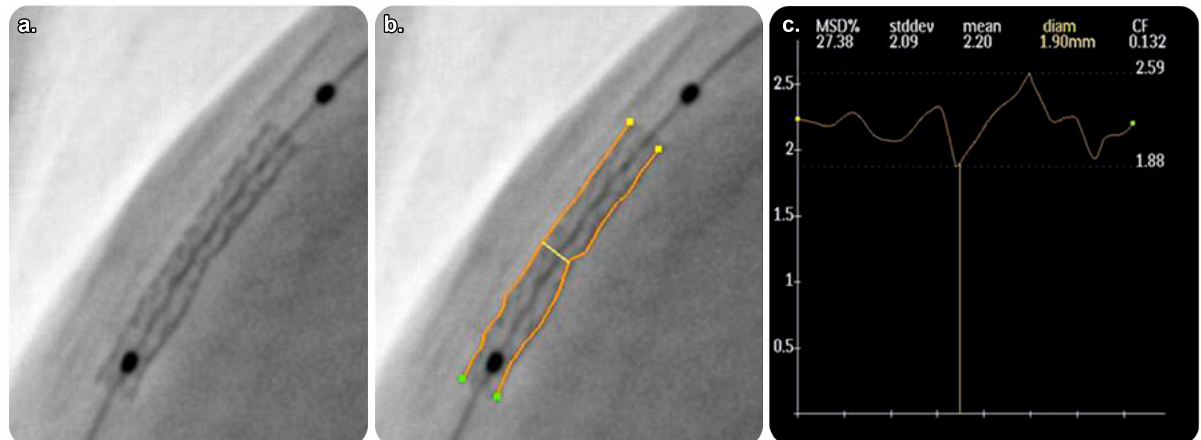
Figure 6. Quantitative analysis of StentBoost software images. ( a ) Enlarged and enhanced StentBoost image. ( b ) Manual tracing of longitudinal stent edges to avoid inadequate stent expansion. ( c ) Minimum stent diameter determined automatically. Reprinted from “Assessment of optimum stent deployment by stent boost imaging: Comparison with intravascular ultrasound” by Tanaka et al. [33] with written approval from the corresponding author and publisher (Heart and Vessels; Copyright 2013).